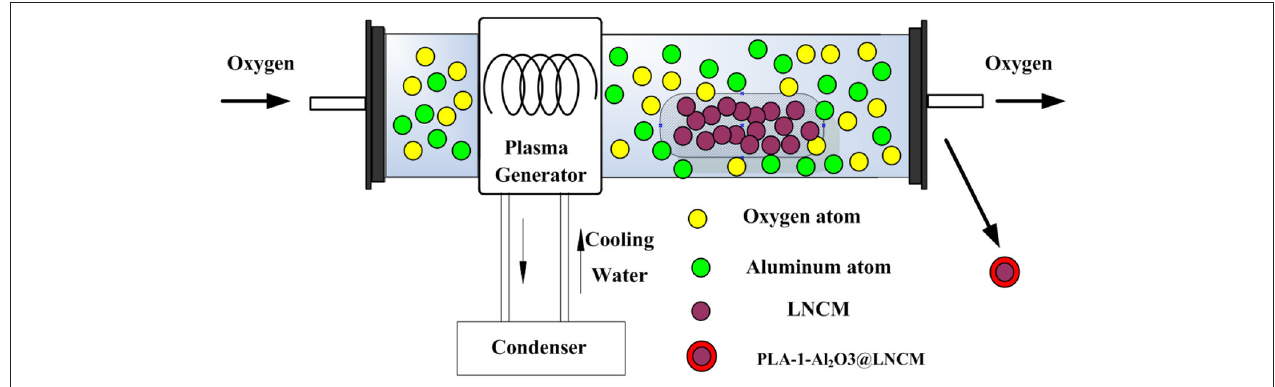
SCHEME 1 | Schematic diagrams for PLA-1-Al 2 O 3